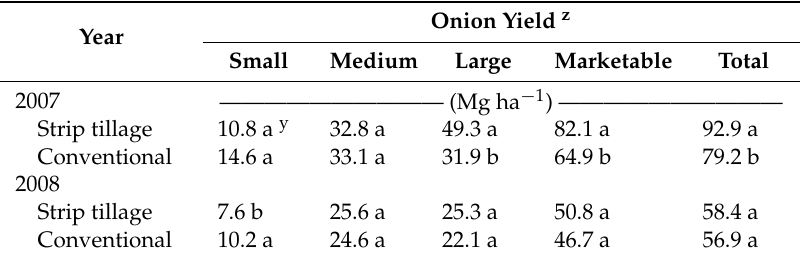
Table 4. Onion ( Allium cepa ) grade and yield as affected by tillage and year averaged over herbicide treatments at Oakes, ND, USA. Onion Yield z Year —————————— (Mg ha ´ 1 )